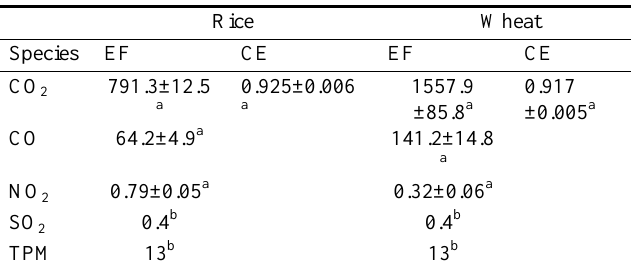
Table 2. Emission factors (g kg -1 ) and combustion efficiency (CE) from burning of rice and wheat straw. a After Zhang et al., 2008, b After Andreae & Merlet, 2001